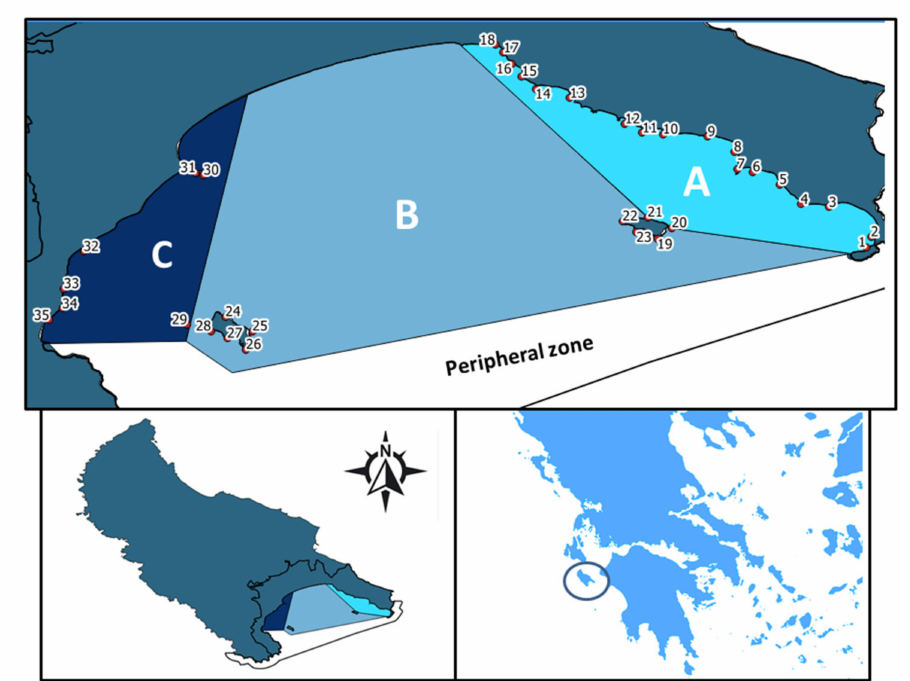
Figure 1. Study area and the 35 sampling sites at each zone (A,B,C and Peripheral) of the marine protected areas (MPA) of the National Marine Park of Zakynthos, Greece (NMPZ) that were sampled during 2009 and